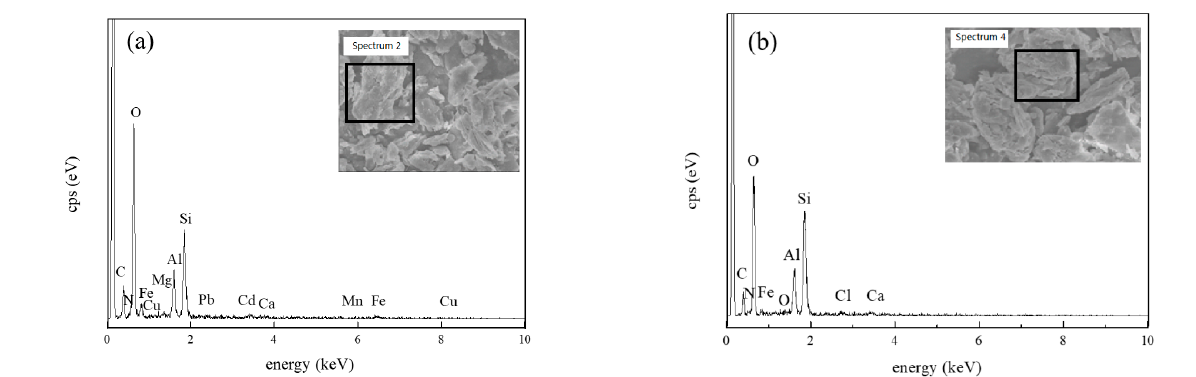
Figure 4. SEM-EDS analysis of soil ( a ) before washing; ( b ) after washing with [Gly][Cl]. Table 4. Properties of the soil ( a ) before washing; ( b ) after washing with [Gly][Cl].